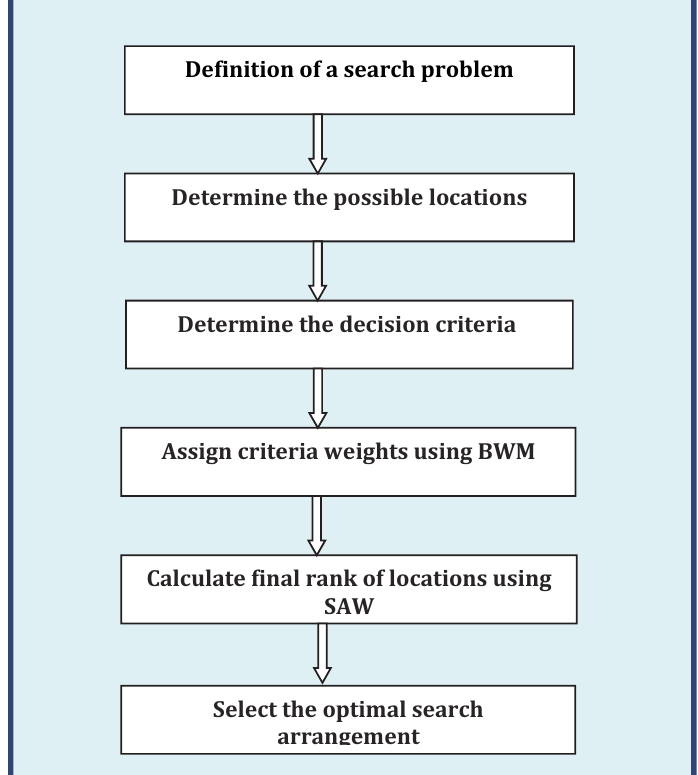
Fig. 1. Flowchart of the suggested model for search